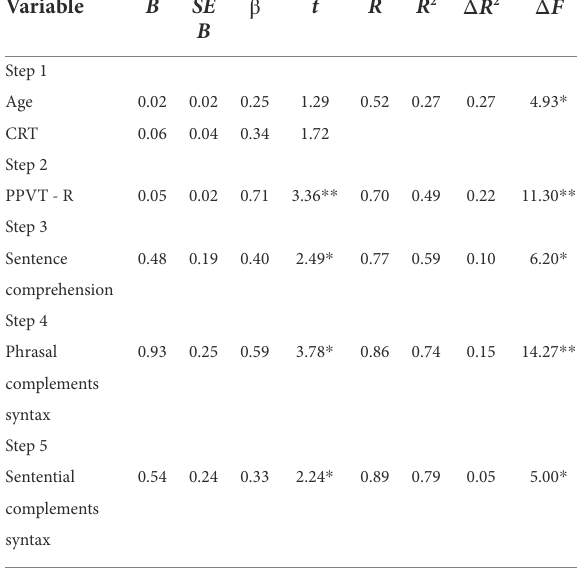
TABLE 2 Regression analysis results of verbal FB for the ASD children.